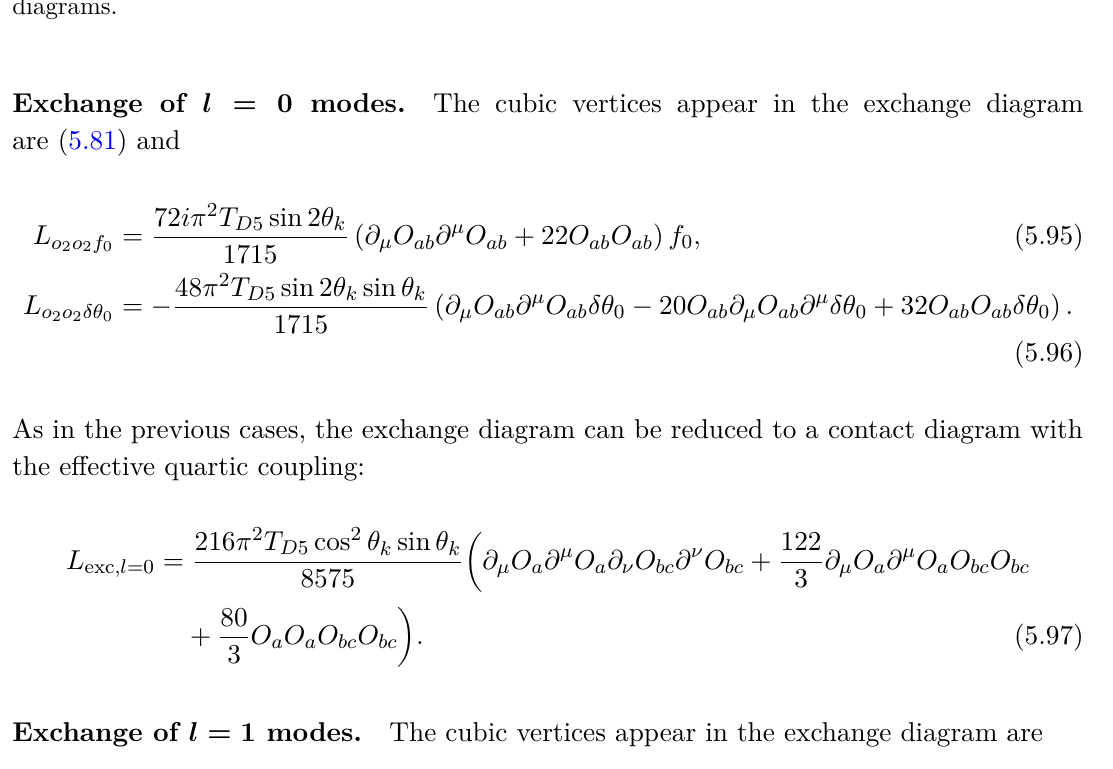
Figure 16. Witten diagrams for computing the connected part of the four-point function h O a O a O a O a i . The l = 0 , 1 , 2 , 3 modes of δθ and a µ fields are exchanged in the exchange 1 2 3 b 3 4 b 4